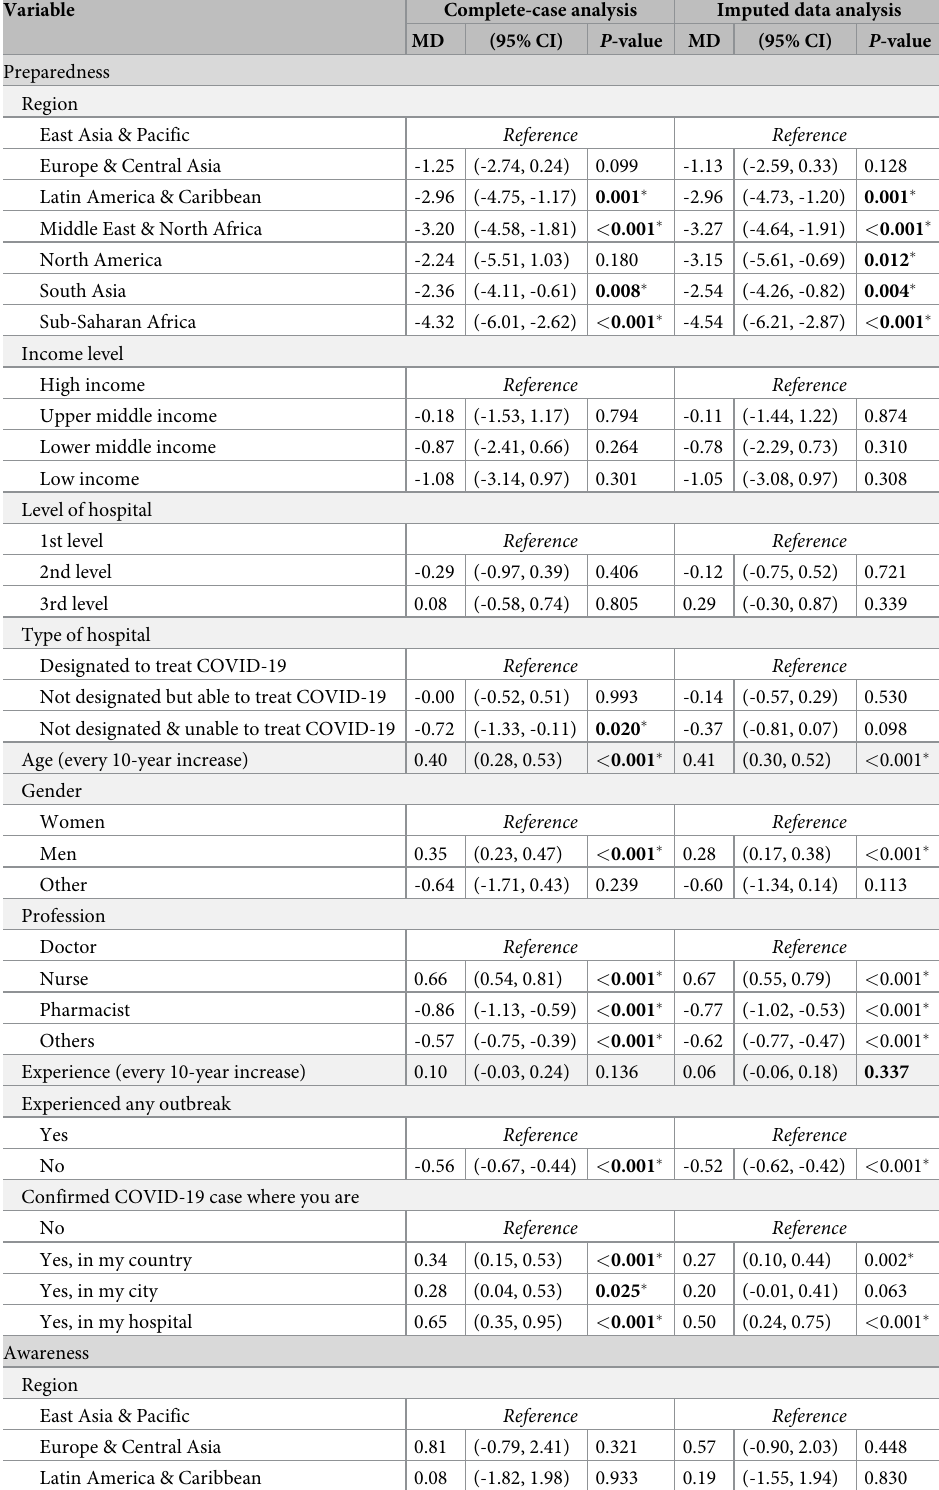
Table 2. Multilevel models for preparedness and awareness scores of participating healthcare